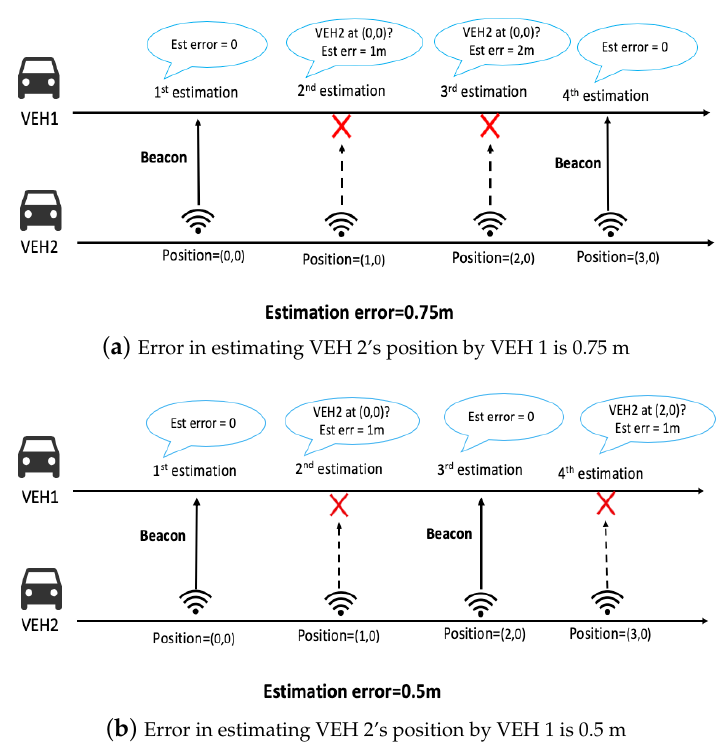
Figure 1. Estimation error of a neighbor’s position can be different even with the same packet delivery ratio